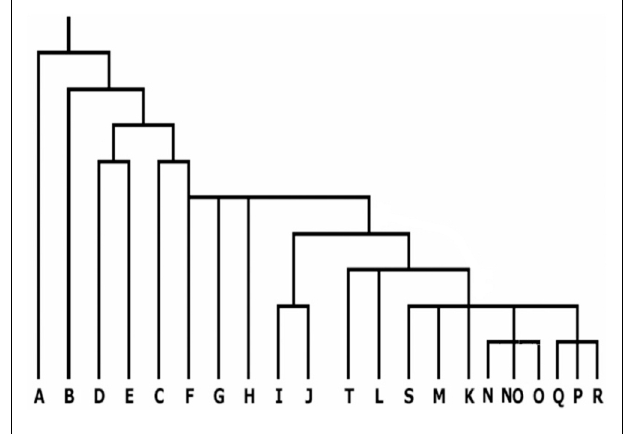
FIGURE 2 | Current phylogenetic relationships of the 20 major haplogroups of the globalY chromosome gene tree (adopted from Chiaroni etal.,